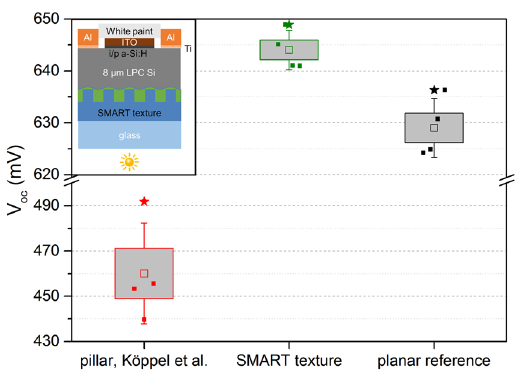
Figure 5. Open-circuit voltage V oc of liquid phase crystallized silicon thin-film solar cell devices (see inset) obtained from Suns- V oc measurements illuminated from the glass side for the planar reference sample, the SMART texture and the hexagonal nano-pillar array published in ref. 11. Open squares represent the mean value of the best four cells (solid squares), boxes the standard error, and whiskers the standard deviation. The highest measured value is indicated by a